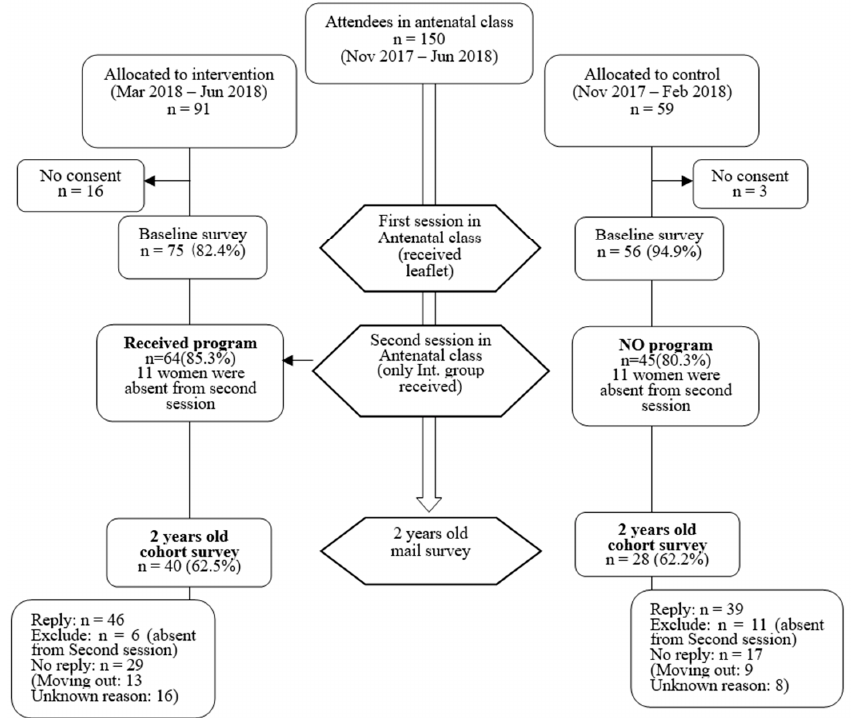
Figure 1. Flowchart of the prospective study. Table 1. Participant characteristics.